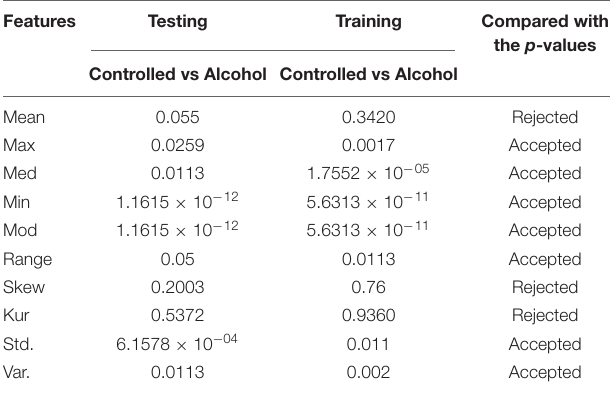
TABLE 3 | Feature set outcome of Experiment No.